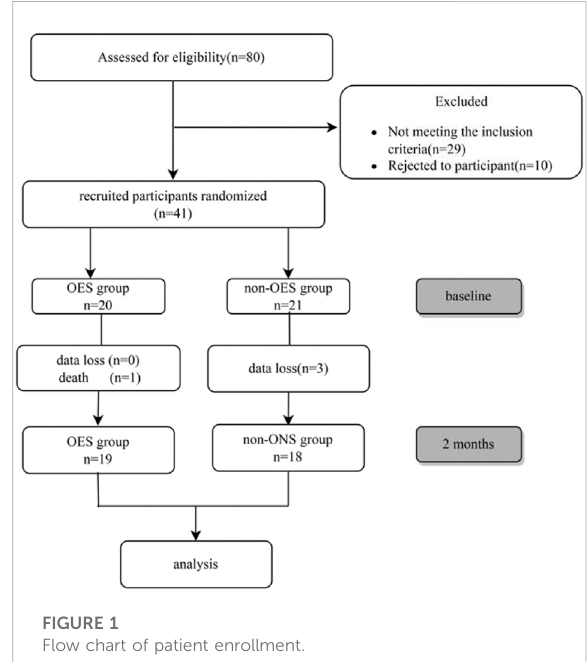
FIGURE 1 Flow chart of patient